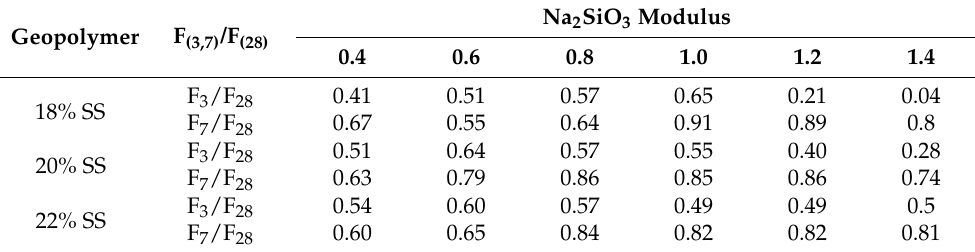
Table 7. The ratio of 3-day and 7-day compressive strength of different geopolymers to 28-day compressive